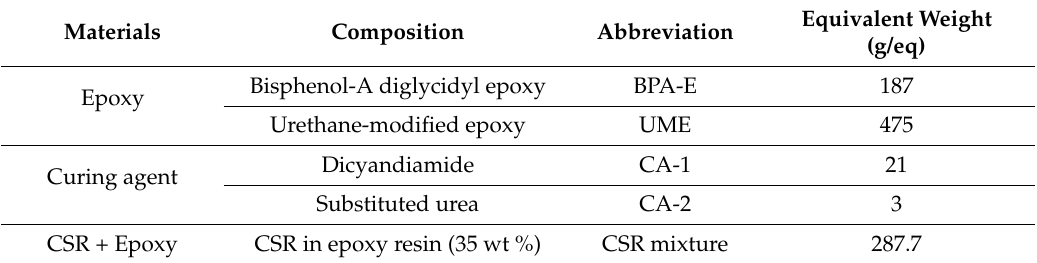
Table 1. Materials used for preparing epoxy composite foam